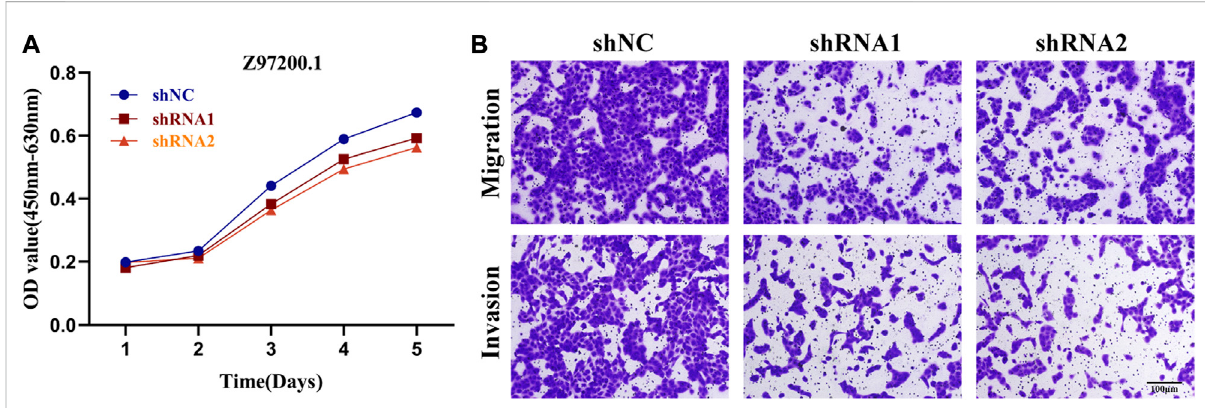
FIGURE 12 Z97200.1 stimulated the proliferation, migration and invasion of ACHN cells. (A) ACHN cells growth rates at 1, 2, 3, 4, and 5 days after knockdownofZ97200.1weremeasuredusingaCCK-8assay. (B) TranswellassayswereconductedtoassesswhetherZ97200.1knockdownaffected the invasion and migration of ACHN